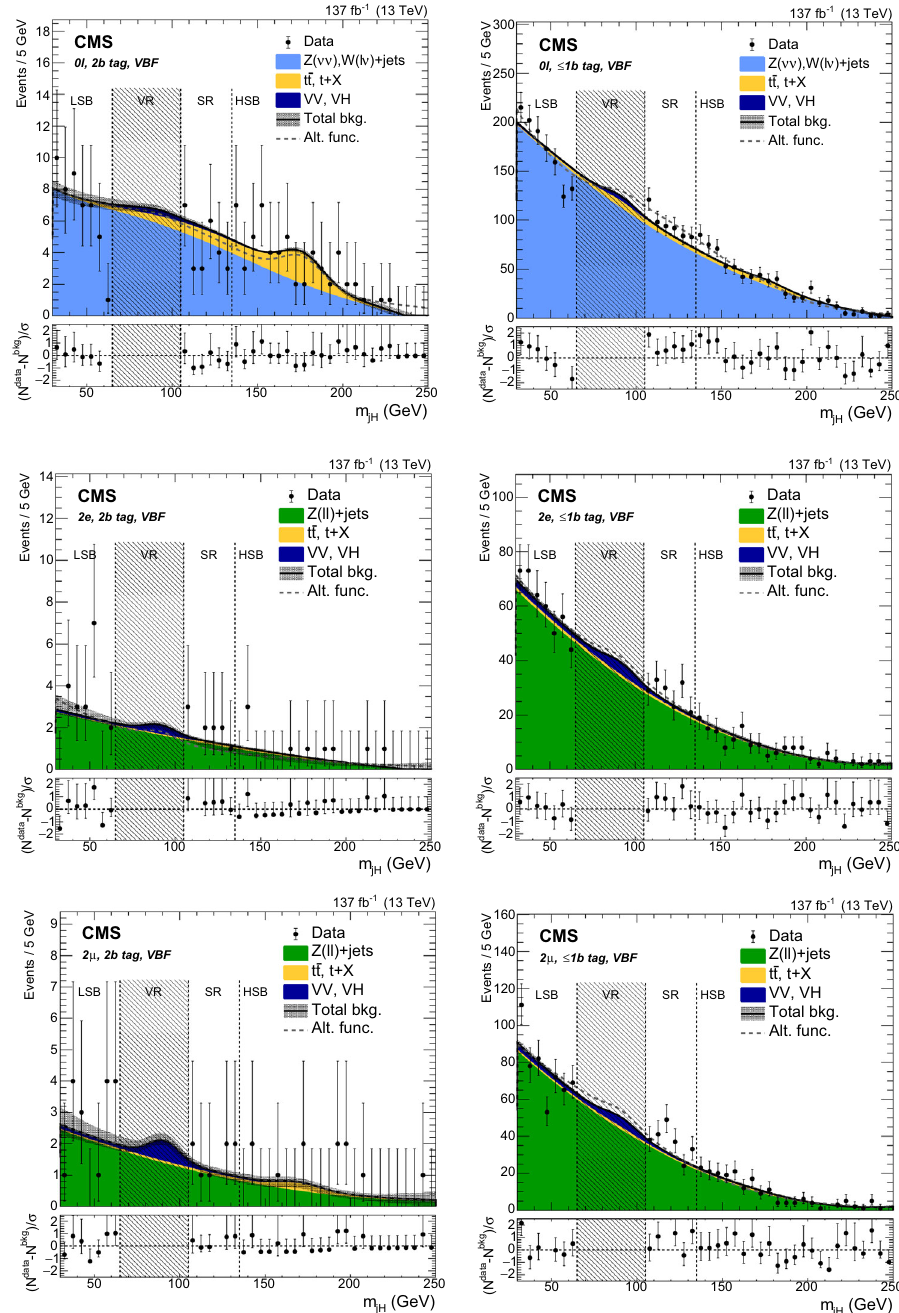
Fig. 4 Fit to the m j H distribution in data in the 2b tag (left column) and ≤ 1b tag (right column) VBF categories, for 0 (cid:4) (upper row), 2e (middle row), and 2 μ (lower row). The shaded bands around the total background estimate represent the uncertainty from the fit to data in the jet mass SBs. The observed data are indicated by black markers. The observed data are indicated by black markers. The vertical shaded band indicates the VR region, which is blinded and not used in the fit to avoid potential contamination from VV resonant signals. The dashed vertical lines separate the LSB, VR, SR, and HSB. The bottom panel shows ( N data − N bkg )/σ for each bin, where σ is the statistical uncertainty in